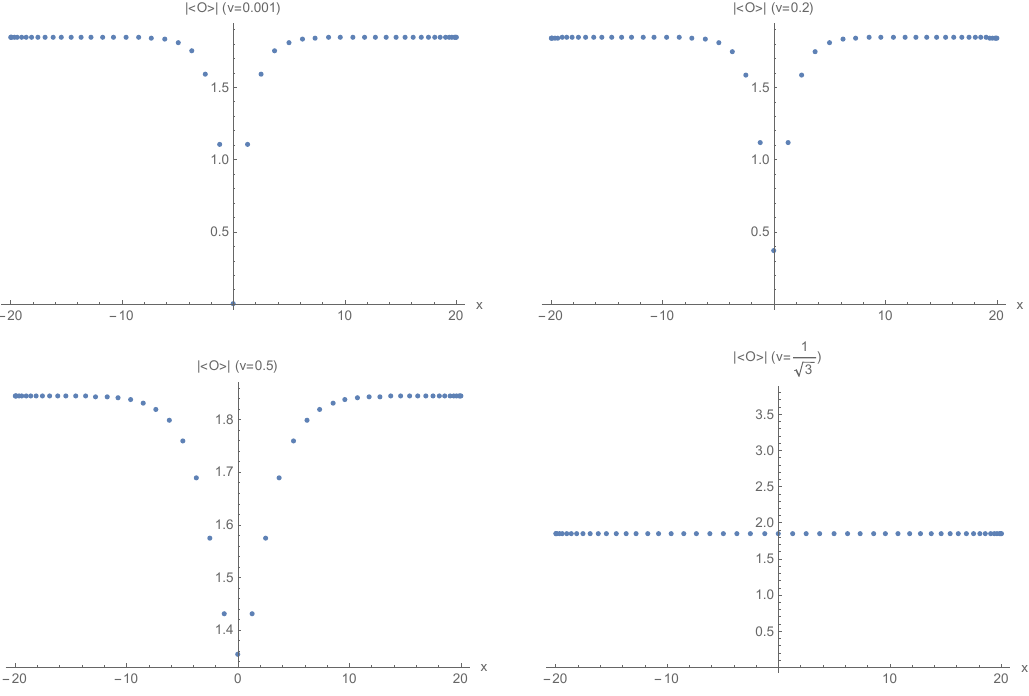
p 3) under are in jh O ij x =20